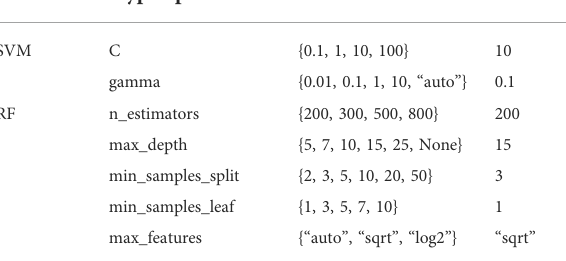
TABLE3ThehyperparametersandcandidatevaluesoftheSVMandRF classi fi er are optimized on both datasets using the RS